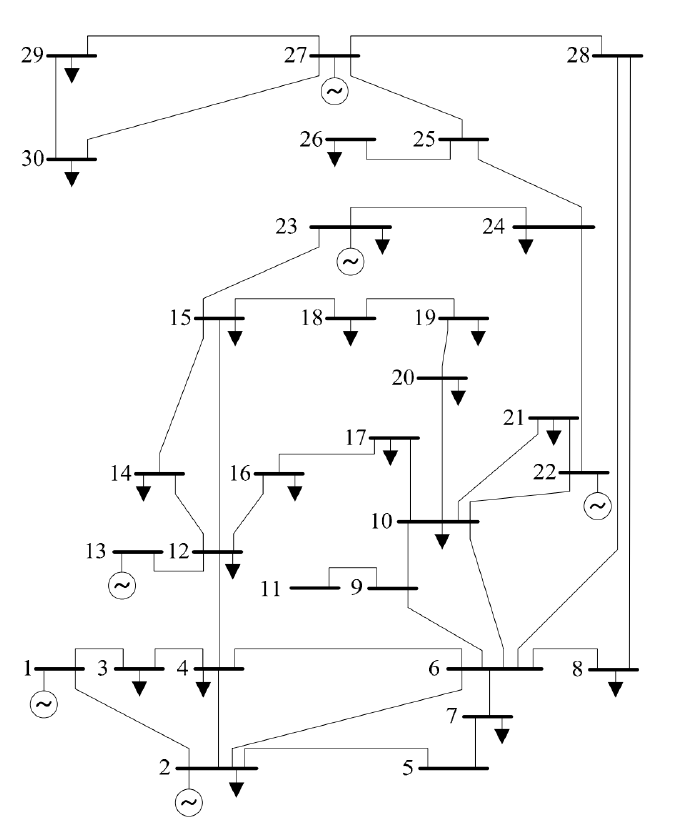
Figure 2. IEEE 30-bus electricity network [28].